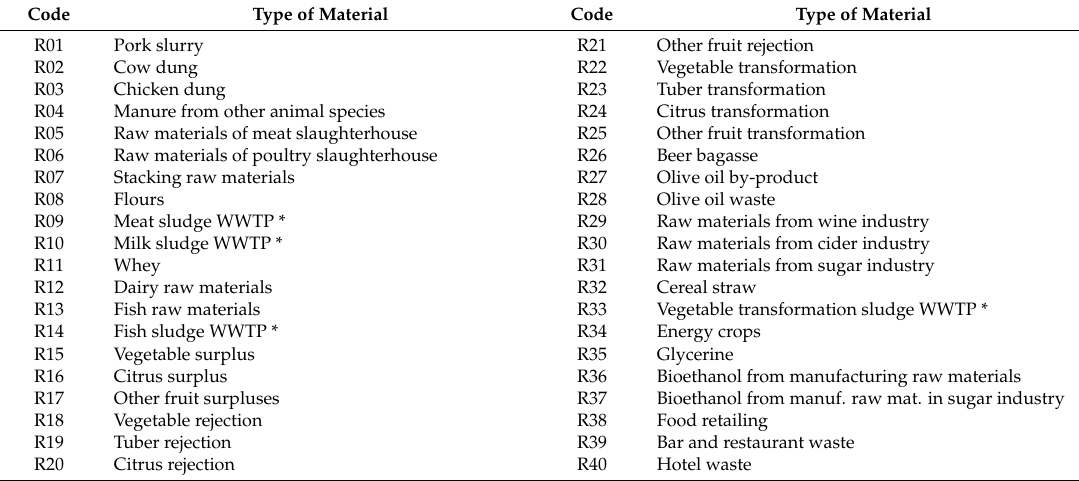
Table 2. Identification of the different types of waste available to be used in anaerobic